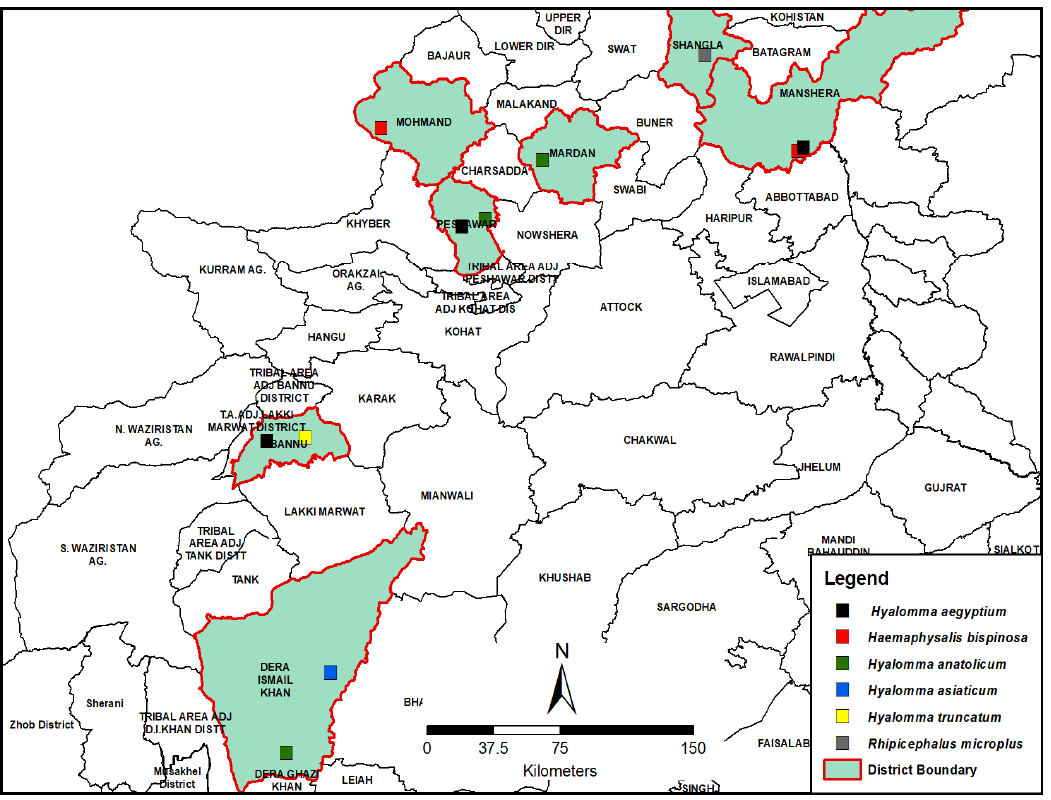
Figure 2. Different sites showing the dominance index of different tick species in KPK, Pakistan.